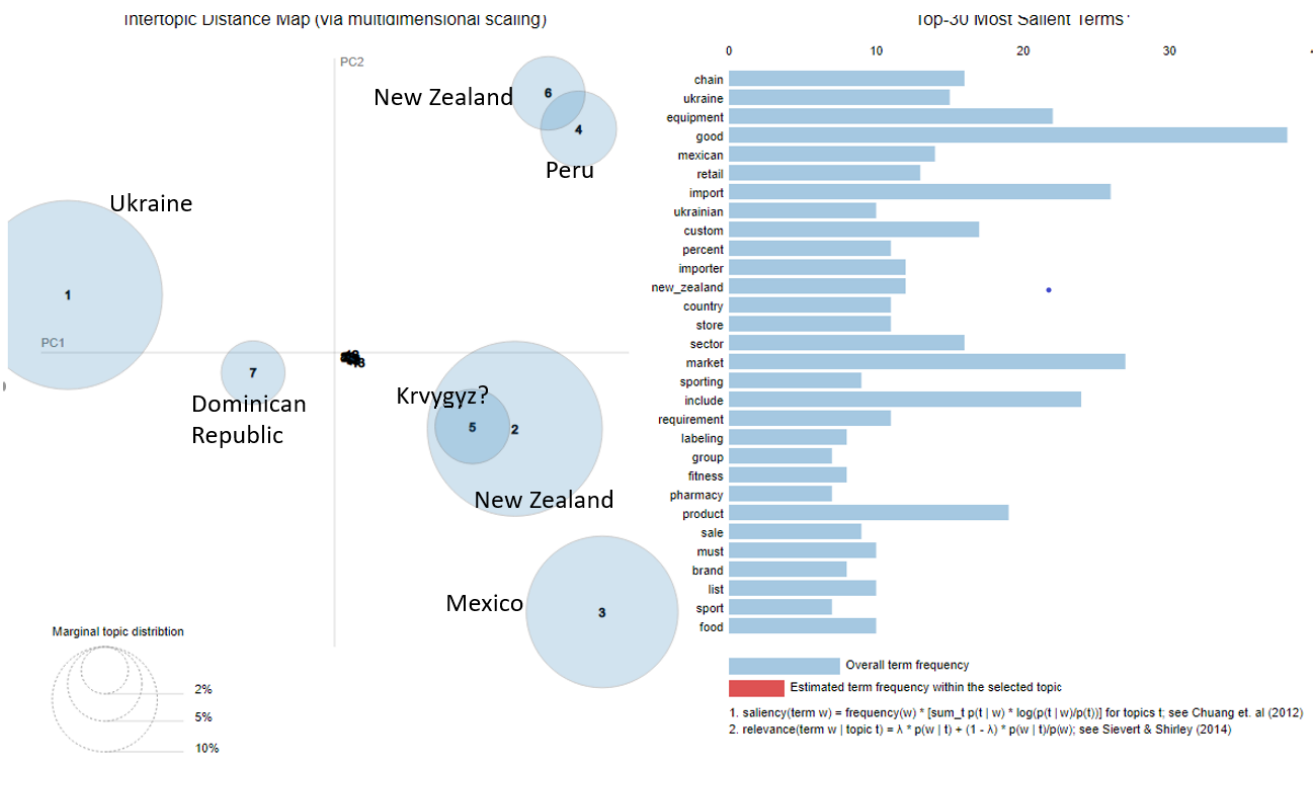
Figure 6. Footwear.